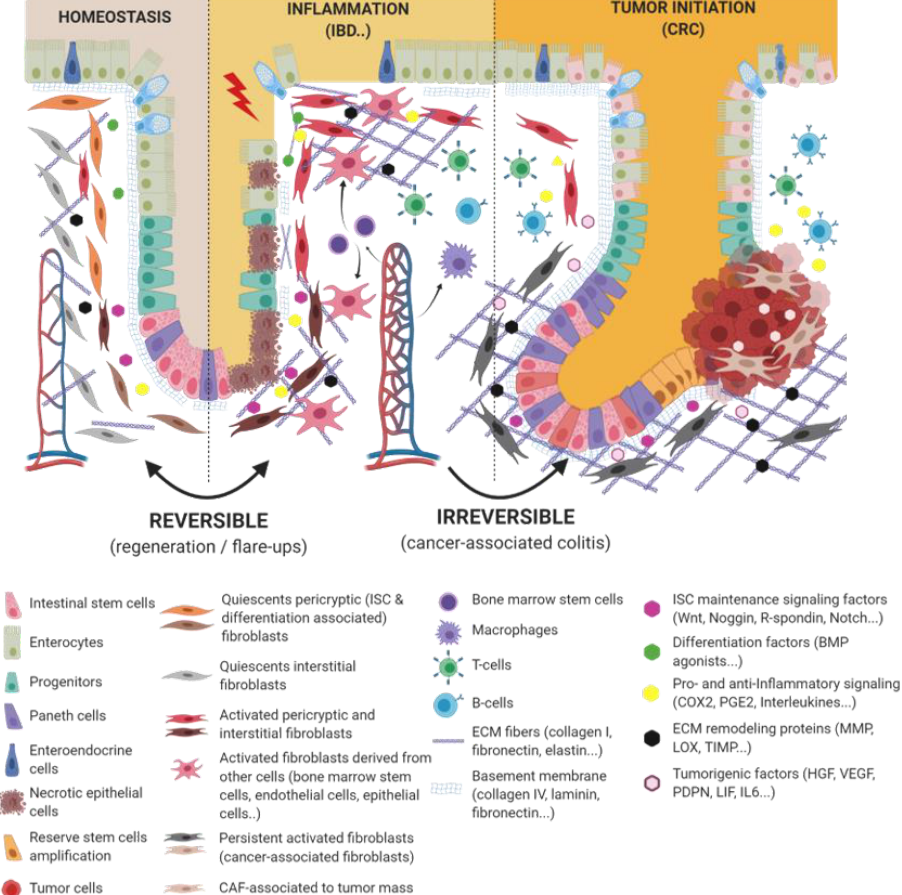
Figure 1. Epithelio-fibroblastic relationship in the physiological and injury context in intestinal tissue. Under the physiological context, normal fibroblasts form a very heterogeneous cell population that could be divide into two families: interstitial fibroblasts (extracellular matrix (ECM) production and regulation) and pericryptic fibroblasts (soluble factors secretion and ECM basement membrane production). Depending on pericryptic fibroblasts’ localization on the intestinal crypt compartment, they secrete (i) proliferating factors for intestinal stem cell (ISC) maintenance (wingless-related integration site (Wnt ligands, R-spondin, EGF, bone morphogenic protein (BMP) antagonists) and constitute an ISC niche or (ii) differentiating factors (BMP family). In the case of acute or chronic tissue injury, not only epithelial cells but also fibroblastic populations undergo a strong remodeling, resulting in ISC loss and/or inability to regenerate epithelium. Depending on the injury severity, resident fibroblasts can be lost or become transiently or definitively activated. Other cell types can differentiate and reach an activated-fibroblast phenotype, thus promoting epithelial regeneration, survival, and immune dialog. Activated fibroblasts can improve epithelial regeneration on a first intention (by increasing some ISC niche factors’ production) and then switch their phenotype to impaired ISC and epithelium